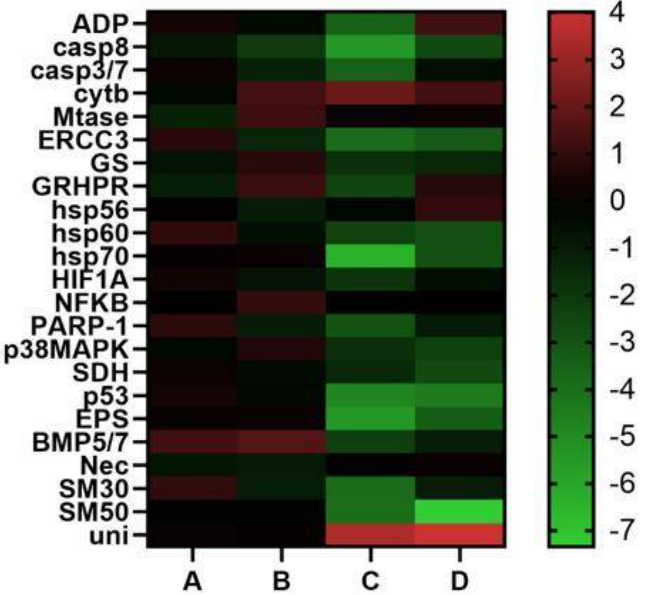
Figure 4. Heatmaps (Heatmapper available at www.heatmapper.ca, accessed on 28 July 2022) show-ing the expression profiles and hierarchical clustering of twenty-three genes analyzed by Real Time qPCR in P. lividus embryos deriving from females A, B, C and D. Color code: red = up-regulated genes with respect to the control; green = down-regulated genes.